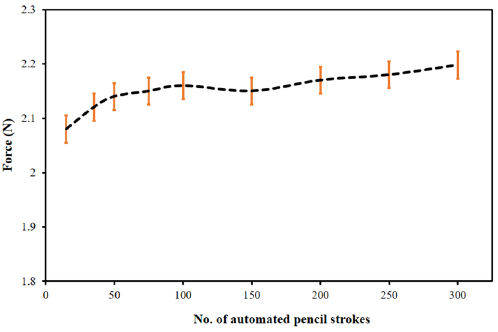
Figure 2. Automated graphite pencil electrode force at the time of fabrication time with a different number of strokes with a standard deviation (n = 3).